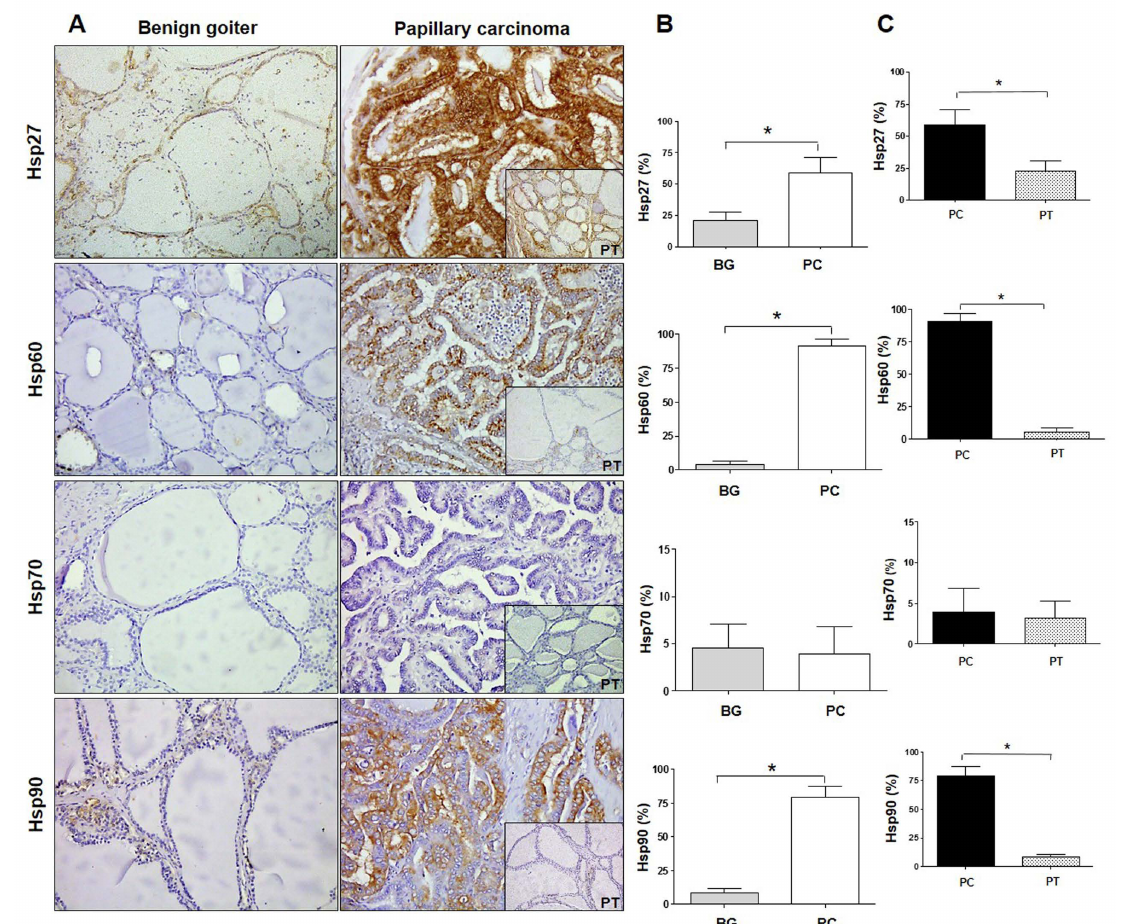
Figure 1. Immunohistochemistry for Hsps in benign goiter and papillary carcinoma. ( A ) Immunohistochemistry images of Hsp27, Hsp60, Hsp70, and Hsp90 in human thyroid tissue of benign (non-toxic) goiter and papillary carcinoma with pertinent normal peritumoral tissue (PT; insets at bottom right of each panel on the right). Magnification 200 × . ( B ) Histograms showing the percentage of immunopositivity for Hsp27, Hsp60, Hsp70, and Hsp90 in benign goiter (BG) and papillary carcinoma (PC). Data are presented as the mean ± SD. * p ≤ 0.0001. ( C ) Histograms showing the percentage of immunopositivity for Hsp27, Hsp60, Hsp70, and Hsp90 in samples of papillary carcinoma (PC) and normal peritumoral tissue (PT). Data are presented as the mean ± SD. * p ≤ 0.0001. The chaperones were also evaluated in healthy peritumoral tissue (PT) of PC samples. In PT